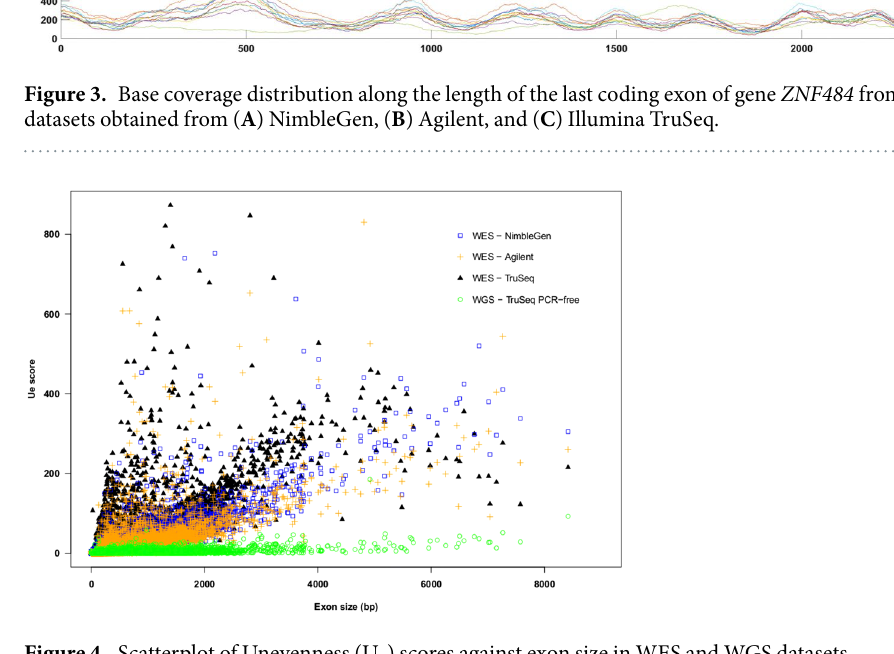
Figure 4. Scatterplot of Unevenness (U E ) scores against exon size in WES and WGS